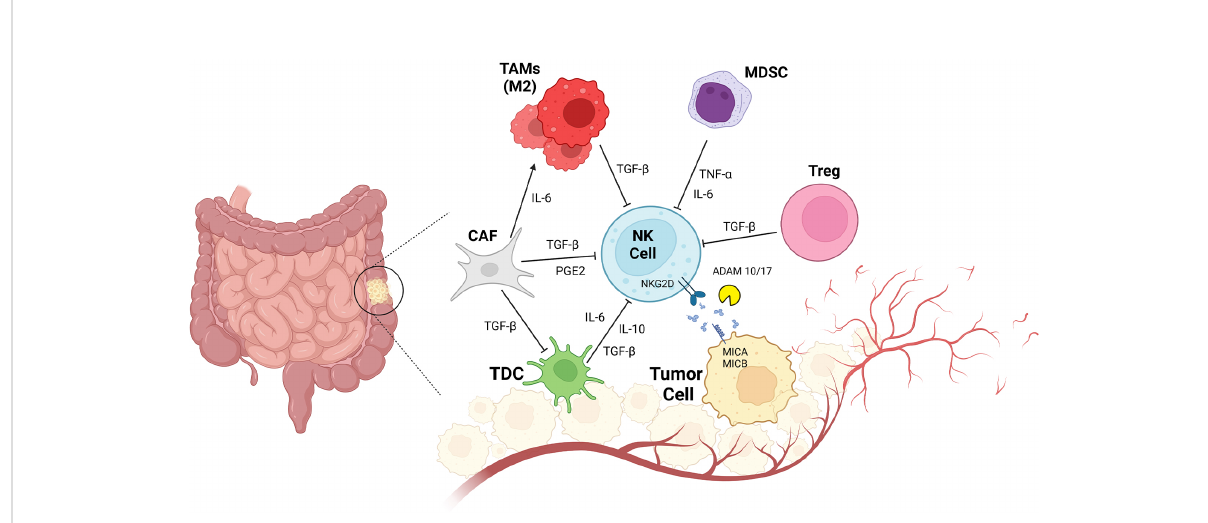
FIGURE 2 CRC and Impaired NK Cell Function due to innate immune cell interactions. Tumor resident innate immunity cells consist of CAF (cancer associated fi broblast), TAMs (tumor associated macrophage), MDSC (myeloid derived suppressor cells), Treg (regulatory T cells), tDC1 (conventional Type1 dendritic cells) interact with NK cells. TGF- b secreted by CAf, TAMs, Treg inactivates NK cells and also DCs in TME. Other regulatory cytokines such as IL-6, IL-10 and TNF a also inhibits NK cells activation. High PGE2 levels makes the NK cells non-responder to tumor cells. Shedding forms of MICA/MICB is a tumor cell direct mechanism to escape from NK cells immune